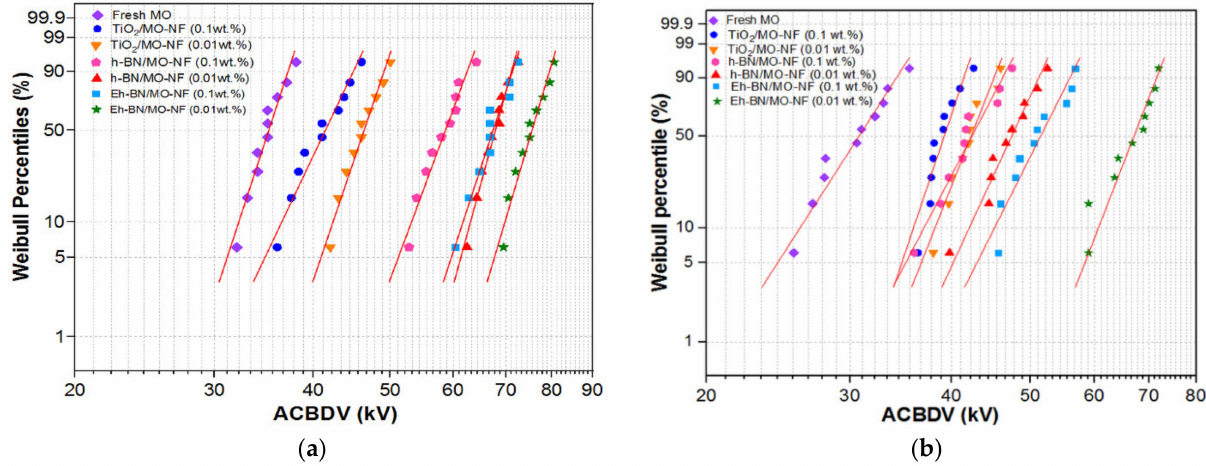
Figure 6. Weibull probability distribution fluid samples ( a ) 18 ppm ( b ) 24